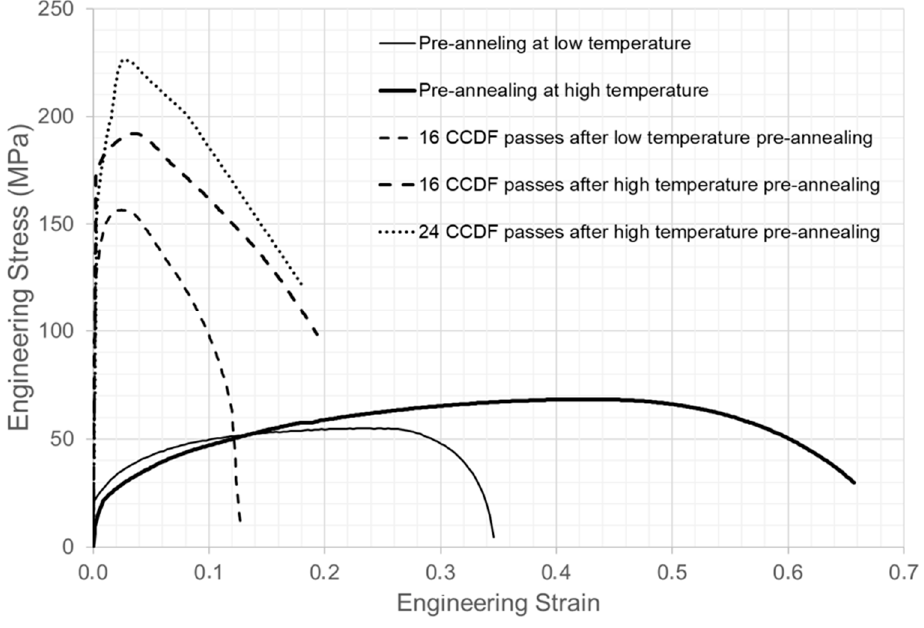
Figure 8. Stress-strain curves of AA1050 after different pre-annealing and CCDF passes.